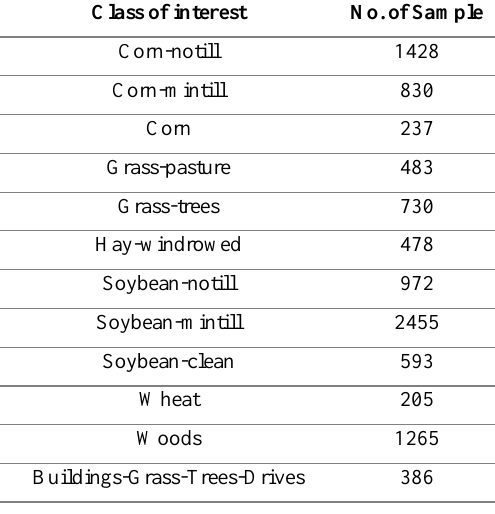
Table 1. Indian pine ground truth specification